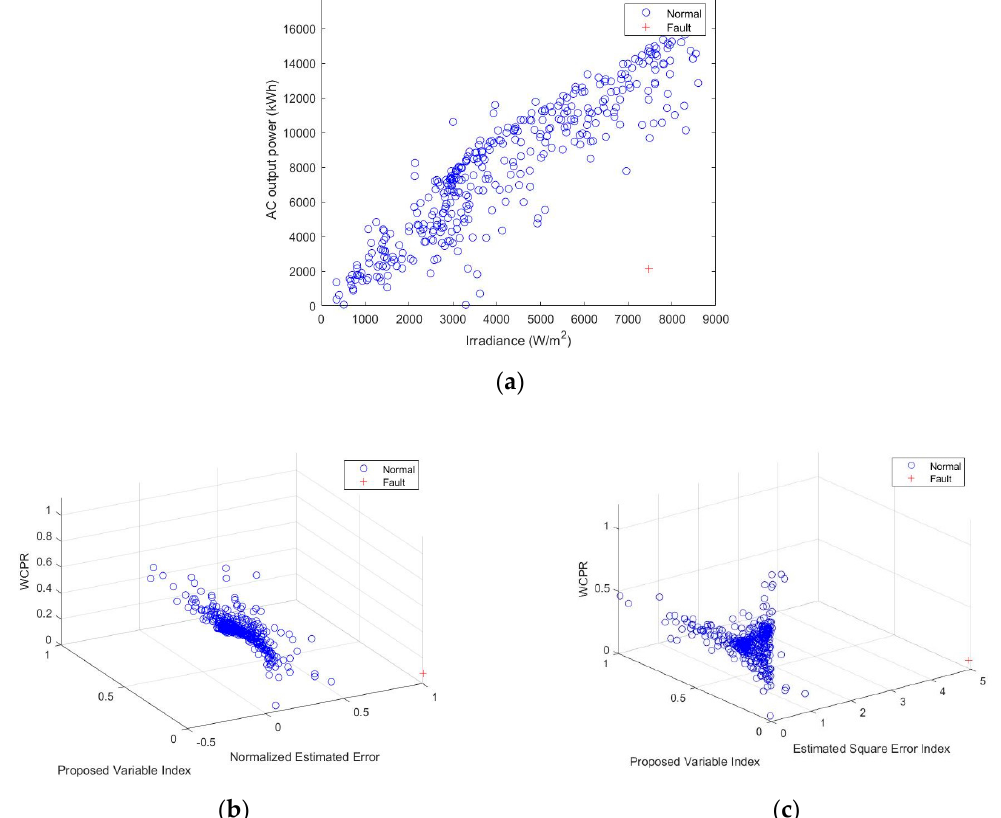
Figure 3. Proposed method of PV fault detection (1-year data). ( a ) One-Class Support Vector Machine (OCSVM); ( b ) OCSVM with the proposed variable index of the linear kernel function; ( c ) Estimated Error Matrix (EEM)-OCSVM with the proposed variable index of the linear kernel function. Table 6. The classification accuracy of OCSVM, OCSVM with the proposed variable index of the linear kernel, EEM-OCSVM with the proposed variable index of the linear kernel (5 years of daily data, 1825 data sets).